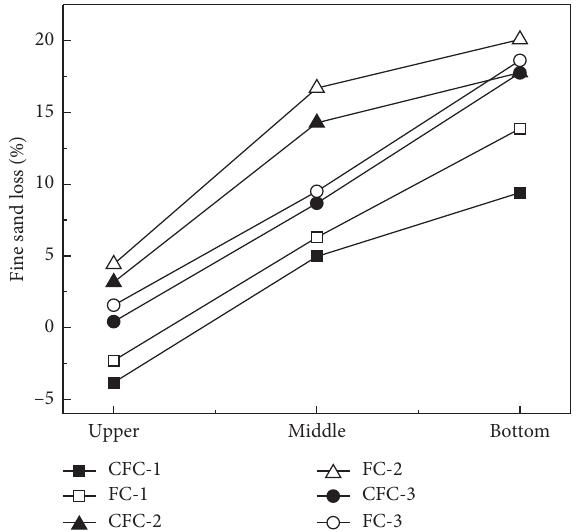
Figure 9: Percentage of fine sand loss for CFC and FC